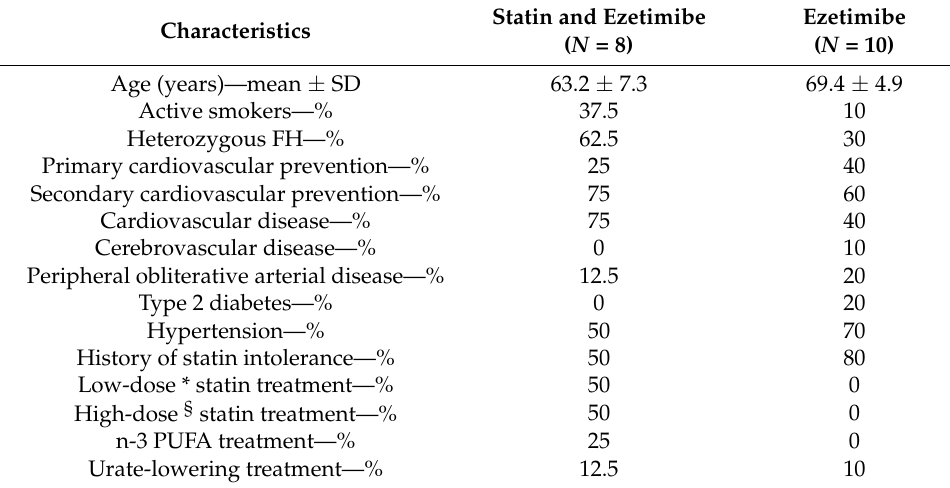
Table 1. Baseline clinical characteristics of the cohort.